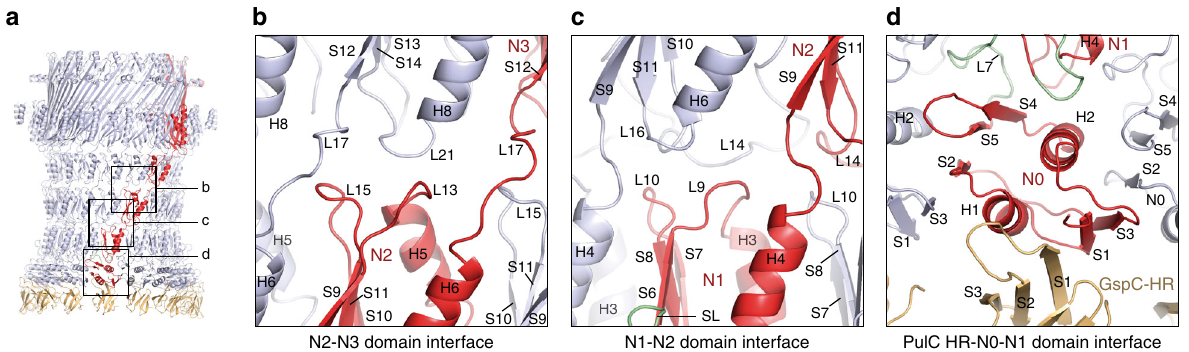
Fig. 5 Structural analysis of the outer membrane complex (OMC) periplasmic domains. a Overview model of the OMC with PulS removed for clarity. Boxed regions are zoomed in b – d . b – d Cartoon representation of selected domain interfaces showing key structural